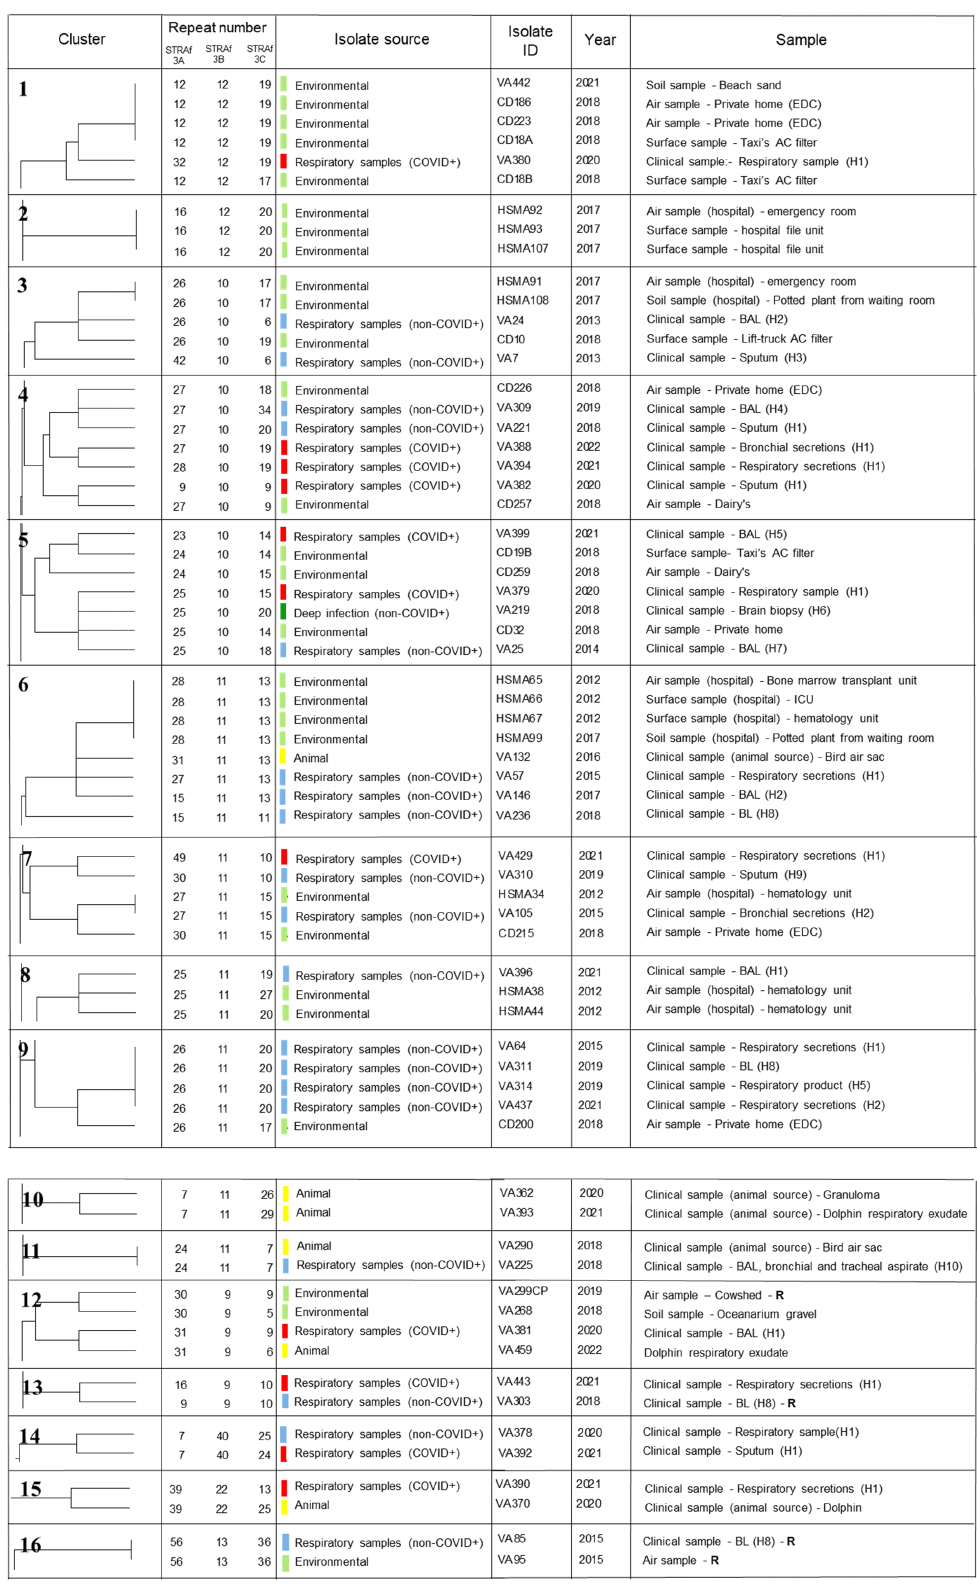
Figure 2. Groups of isolates showing genetic relatedness obtained from the dendrogram constructed in Bionumerics 6.6. software (Applied Maths, bioMérieux SA, Marcy-l'Étoile, France) using a cate- gorical similarity coefficient and an unweighted pair group method with arithmetic mean (UPGMA) analysis. AC–air conditioner; EDC–electrostatic dust collector; BAL–bronchoalveolar lavage; BL–bronchial lavage; H1 to H10 –hospitals’ ID (from where the isolates were collected); R–resistant to azoles. Isolates collected from COVID-19+ patients are heterogeneously scattered through the dendrogram. Each one of these isolates presents a unique microsatellite multi-locus genotype, as referred to above. Yet, in cluster #4, isolates VA388 and VA394 are closely related, presenting a difference of only one repeat unit in one of the loci. Isolate VA382, also from cluster #4, shares only one allele with VA388 and VA394 isolates, which are genetically closer to CD257, an environmental isolate (sharing two alleles). Cluster #14 includes isolate VA392, which shares two alleles (STR Af 3A and 3B) with a non-COVID respiratory product, VA378, which shows a difference of one repeat unit in STR Af 3C. Isolates VA390 and VA394 were collected from the same patient (two days apart). These isolates did not cluster together, and their multi-locus genotypes were completely differ- ent. This can represent a mixed infection with two different strains at the same time, a fact that is known to happen with A. fumigatus infections [34]. In other groups that do not include A. fumigatus isolates from patients positive for COVID-19, it is possible to perceive that some clusters are formed by isolates with exactly the same microsatellite multi-locus genotype: clusters #1 and #6 comprise four environ- mental isolates each with the same genotype, and cluster #9 comprises four isolates from respiratory samples also presenting the same genotype. Some other clusters, namely #2, #3, #7, #11, and #16 also include genotypes that are not unique and are shared between two or three isolates. The remaining isolates presented in Figure 2 all showed a unique genotype, even though some of them share one or two alleles with one or more isolates (Supplementary Figure S1). Cluster #10 includes two isolates collected from animals that are closely related and differ only in one allele. 3.3. AfumID The isolates enrolled in our study were included in the database AfumID (https://afu- mid.shinyapps.io/afumID/ (accessed on 21 June 2022). Figure 3 shows how the COVID+ isolates take place among the ones already inserted in the database (A), and how the set of all isolates of our study are scattered throughout the database (B). The orange dots cor- respond to the susceptible isolates from the database, the blue dots represent the resistant ones, and the black dots represent the isolates inserted by us in the database.